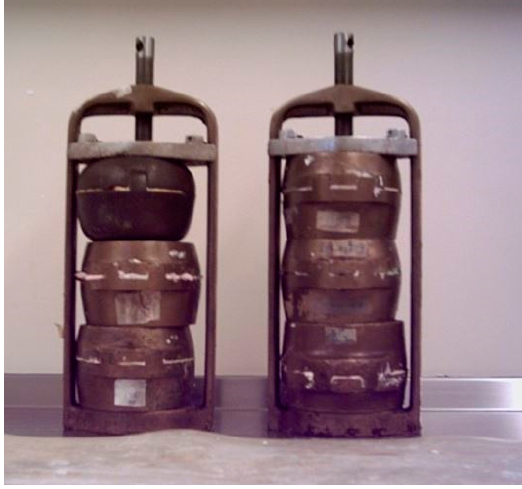
Figure 3. Conventional two-part brass flasks used in dental laboratories.